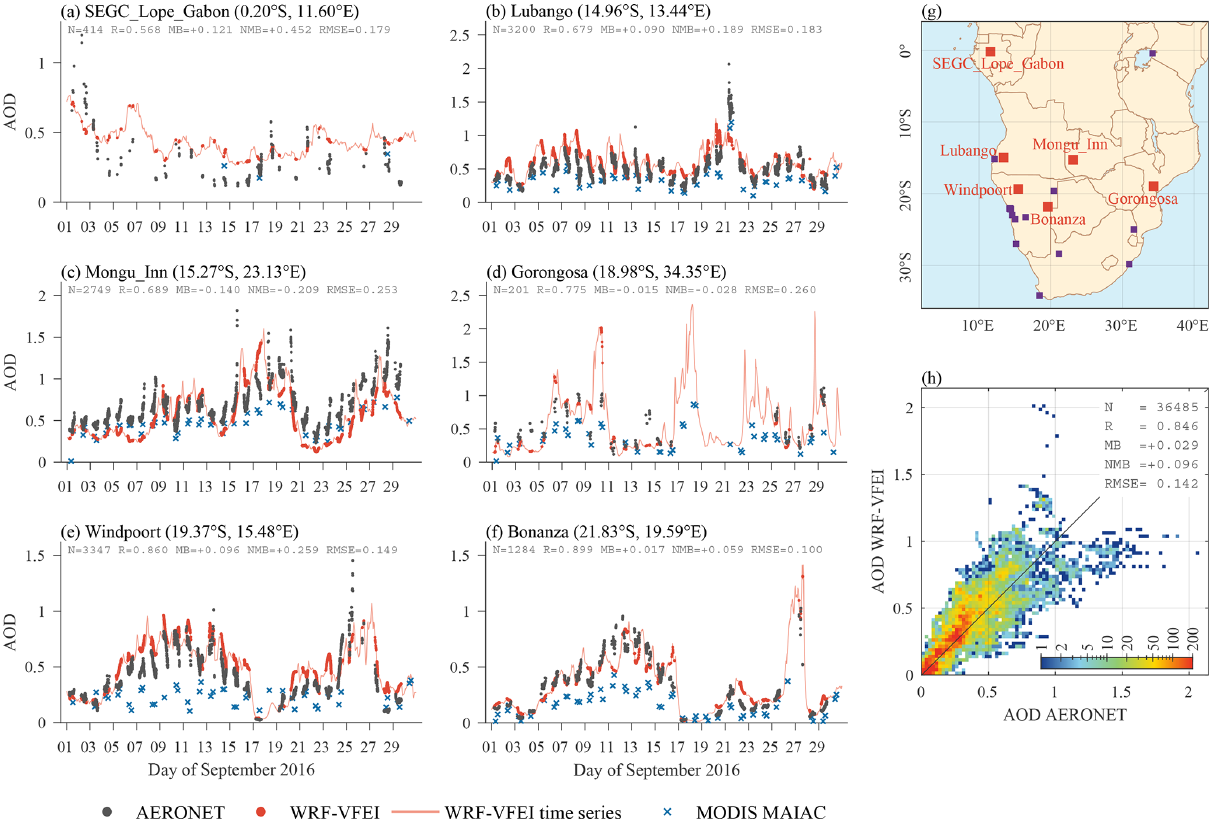
Figure 7. Comparison of aerosol optical depth (AOD) at 500nm between AERONET sites and WRF-VFEI for September 2016. Panels (a) – (f) show the data as time series from six selected sites. AOD data at 550nm from MODIS MAIAC C6.1 at the location of the sites are included as reference. Panel (g) shows the location of the AERONET sites used to evaluate the model simulations. The stations shown in panels (a) – (f) are highlighted in red. (h) Scatter plot displayed as heat map made using data from all the AERONET sites shown in (g) . Statistics are reported in each panel, such as number of points ( N ), correlation ( R ), mean bias (MB), normalized mean bias (NMB), and root mean squared error